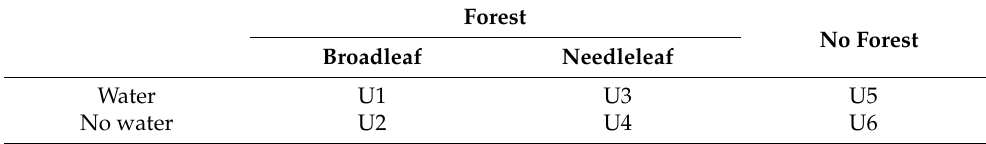
Table 1. Behavioral states defined according to the different resources available at different habitats. Forest No Forest Broadleaf Needleleaf Water U1 U3 U5 U4